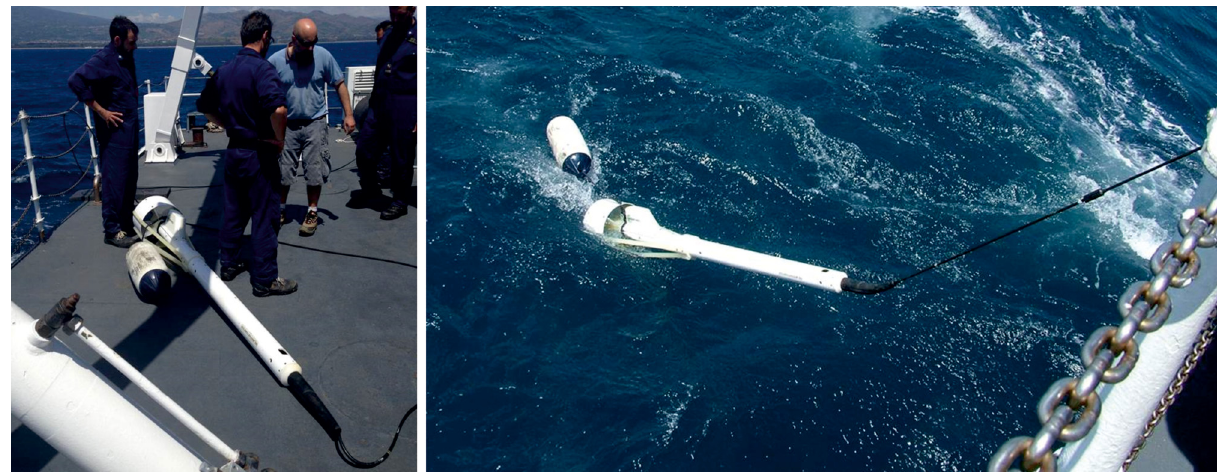
Figure 4. The Geometrics G880 caesium-pumped marine magnetometer on board the H/V “Galatea” (left) and during its deployment (right) together with a small floating tool to guaranty the correct and safety